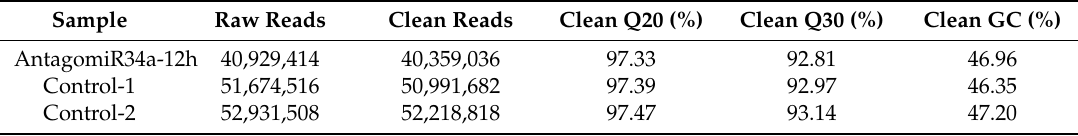
Figure 1. The relative expression level of miR-34a in livers of fishes treated with high starch diet. All fishes were treated with 80 nmol/100 g body weight miR-34a inhibitors (antagomiR-34a) for 12, 24, and 48 h, combined with high starch diet (45% wheat starch). Relative expression levels of miR-34a was detected using qRT-PCR. *** notes p < 0.001 vs. control. Table 1. Summary of the sequencing data from M. amblycephala .